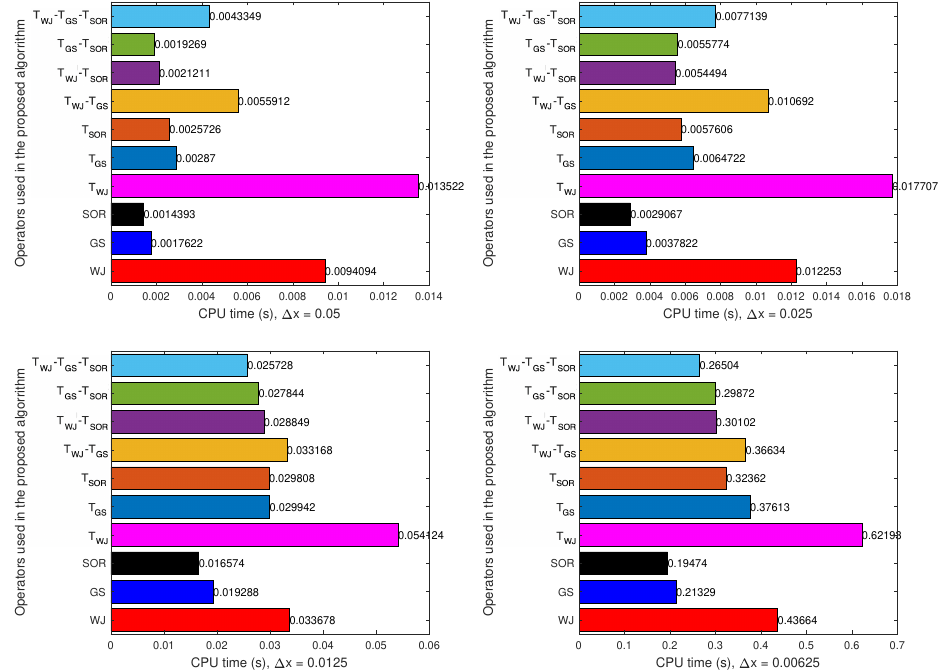
Figure 9. The evolution of the CPU time for the GS, WJ, and SOR methods and the proposed method in solving problem (20) with ϑ = 25 and t ∈ ( 0,1 ] .